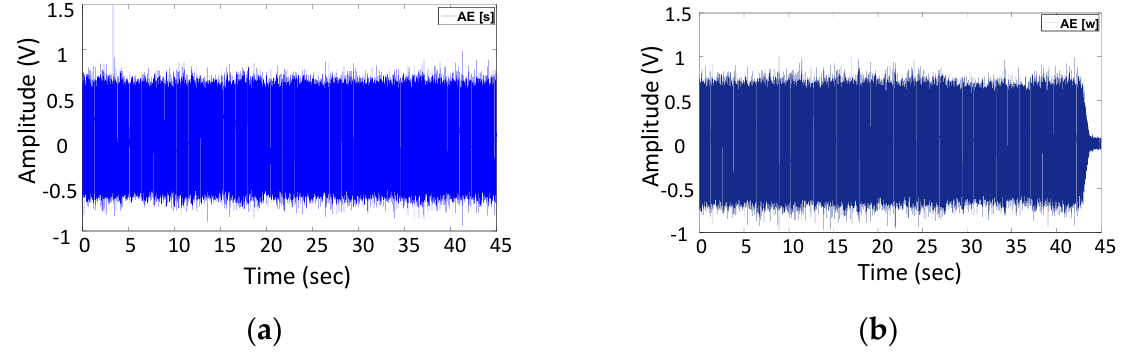
Figure 10. Time domain AE signal: ( a ) sharp tool; ( b ) worn tool.